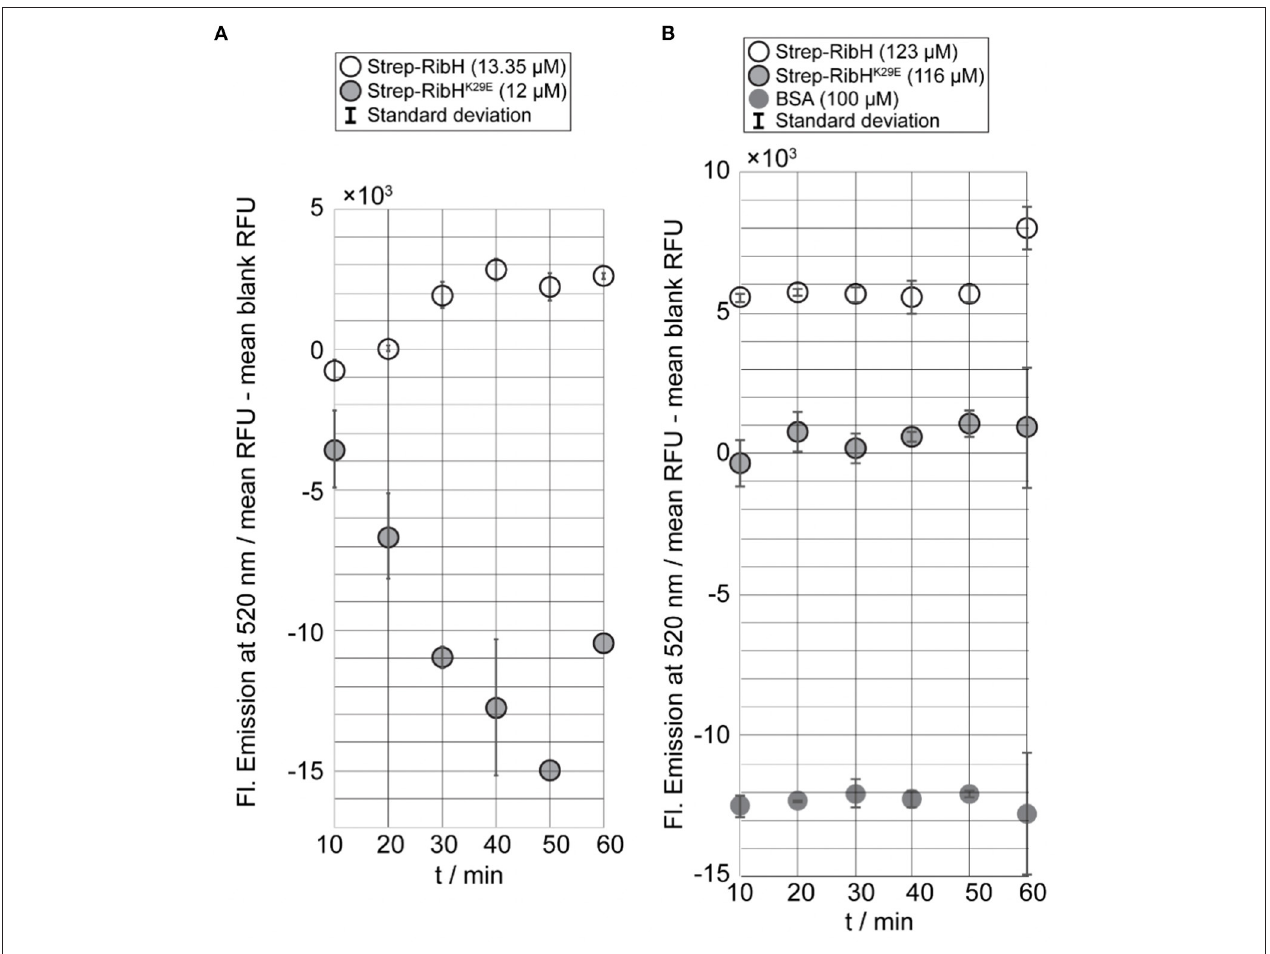
FIGURE 5 | Kinetic end point assay using GNAT RibT-His 6 and different concentrations of probed acceptor substrates and controls. Reactions were initiated by the addition of the GNAT enzyme to acceptor substrate and allowed to proceed at room temperature for the indicated time intervals (10min) until reactions were quenched. After quenching fluorescence was developed, the samples were excited at 320nm, and resulting fluorescence was measured at 520nm. Prior to plotting, blank values had been subtracted from measured sample values. All the samples have been prepared in duplicate, and their respective standard deviation is shown within the bars (except for the last two data points of Strep-RibH K29E when 12 µ M was used because only one value was measured in both cases). (A) Results of kinetic end point assay using a constant concentration of RibT-His 6 (100nM) with Strep-RibH (13.25 µ M) and Strep-RibH K29E (12 µ M). (B) Results of kinetic end point assay using a constant concentration of RibT-His 6 (100nM) with Strep-RibH (123 µ M), Strep-RibH K29E (116 µ M), and BSA (100 µ M).